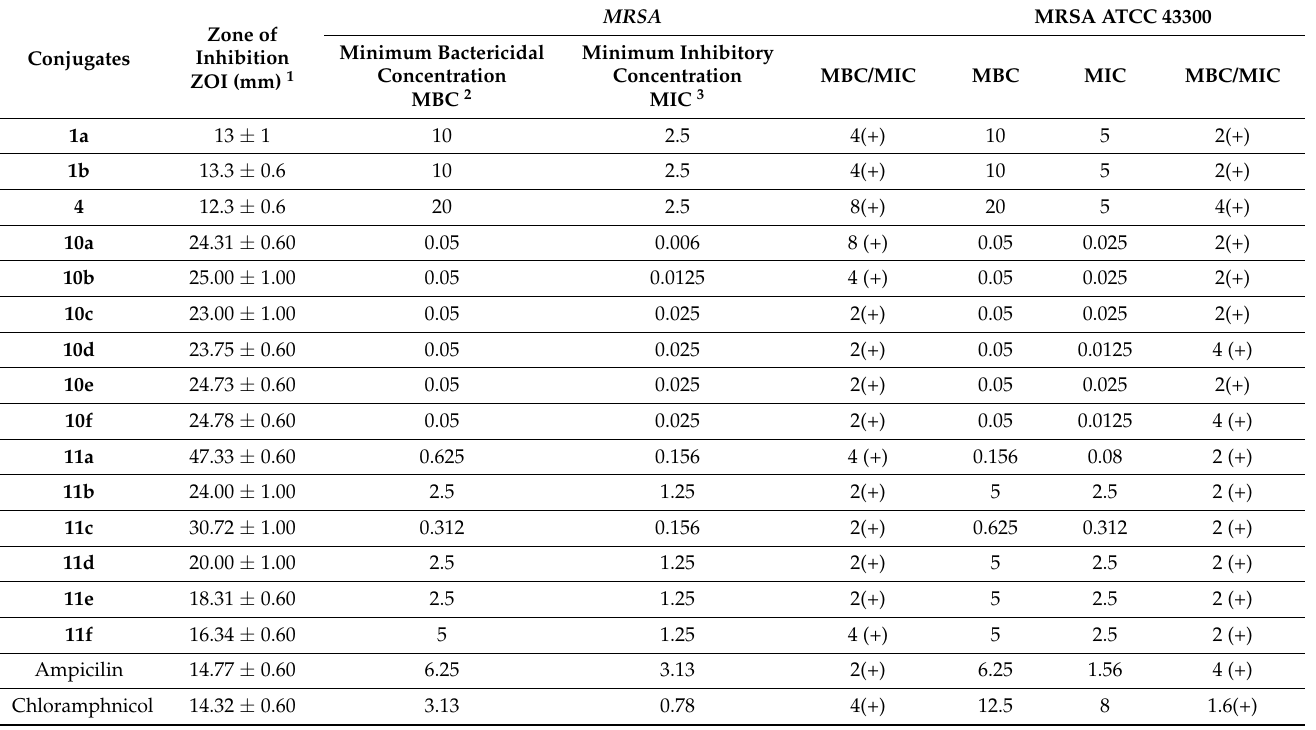
Table 2. Antibacterial activity of conjugates 10a – f and 11a – f against MRSA clinical